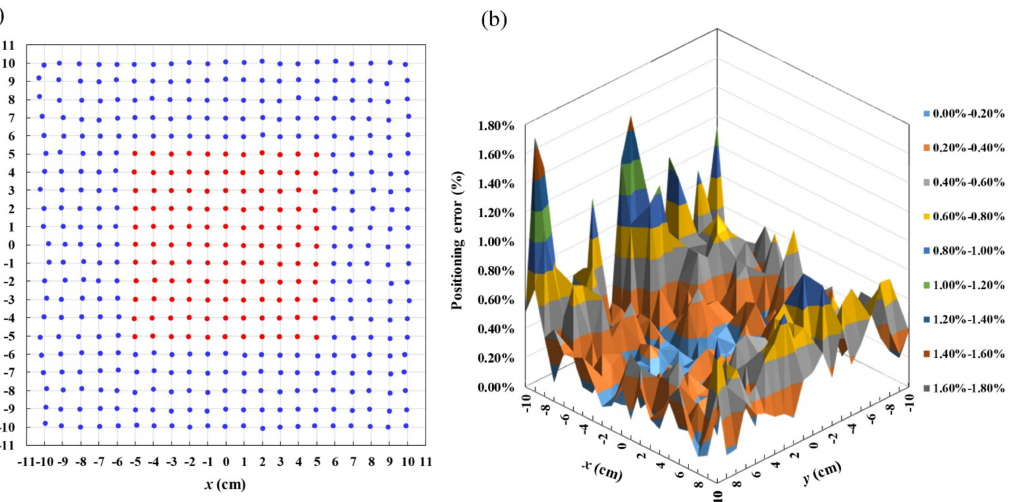
Figure 11. Retrieved coordinates and positioning errors of the 2D position-tracking system using GMR spin-valve sensor. ( a ) Retrieved 441 sensor positions in real time with grid size of 1 cm × 1 cm and ( b ) positioning error of tracking